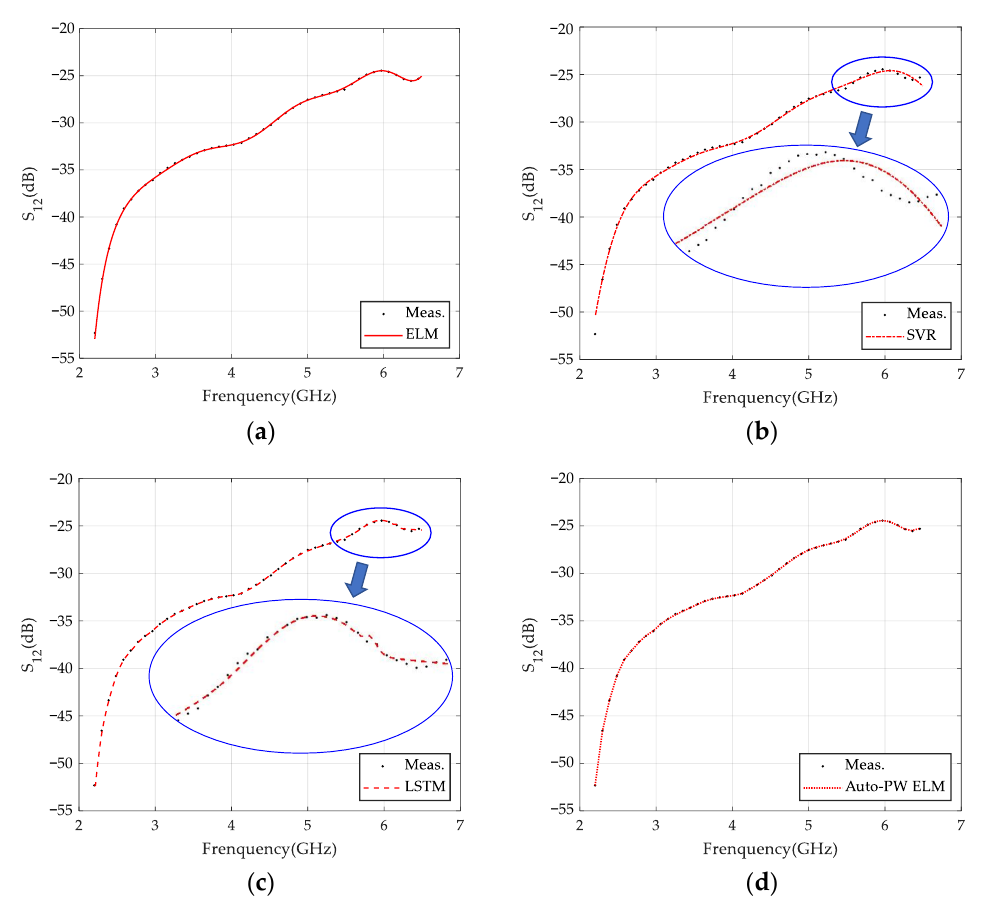
Figure 7. Modeling results of S 12 parameters. ( a ) Comparison of ELM model and measured data. ( b ) Comparison of SVR model and estimated data. ( c ) Comparison of LSTM model and measured data. ( d ) Comparison of automatic piecewise ELM model and measured data.